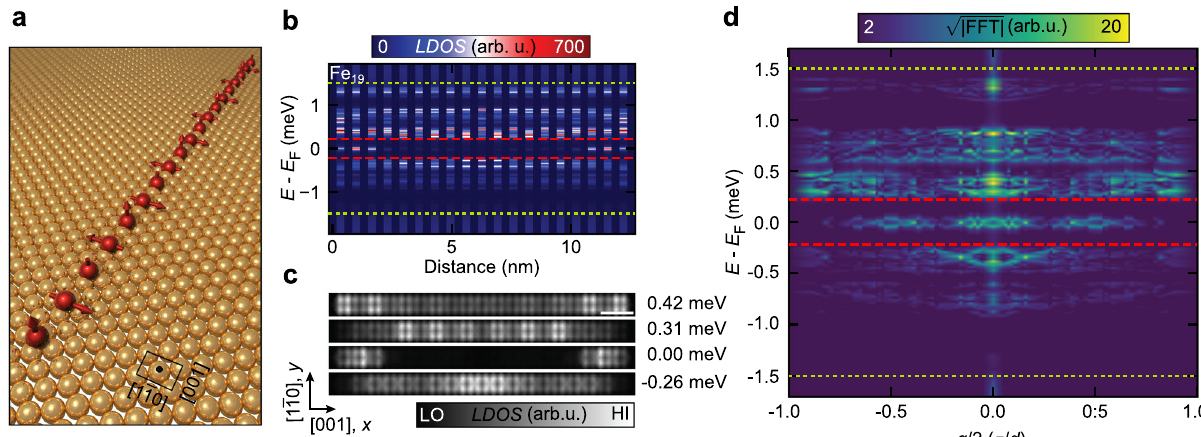
Figure 5 Minigap and Majorana bound state (MBS) enforced by helical spin spirals in Fe chains on Au monolayer. a Illustration of the helical spin spiral state (red arrows) with a rotation angle of 90 ∘ of a chain containing 19 Fe atoms (red spheres) assembled on the lattice of Au atoms (golden spheres) on Nb(110) (not visible). b Electron component of the local density of states (LDOS, given in arbitrary units, arb. u.) extracted along the longitudinal axis (distance x ) of a Fe 19 2 a − [001] chain in the helical spin spiral state shown in panel ( a ). c The spatial distributions of the LDOS evaluated in the fi rst vacuum layer above the Fe 19 2 a − [001] chain at the energies indicated to the right of each panel. d Dispersion of scattering wave vectors averaged from the one-dimensional fast Fourier transforms (1D-FFT) of the calculated LDOSs of the Fe N 2 a − [001] chains including N = 9, 11, 13, 14, 17 and 19 Fe atoms (Supplementary Fig. 8). The green and red dashed lines in ( b and d ) indicate the substrate gap and the minigap,